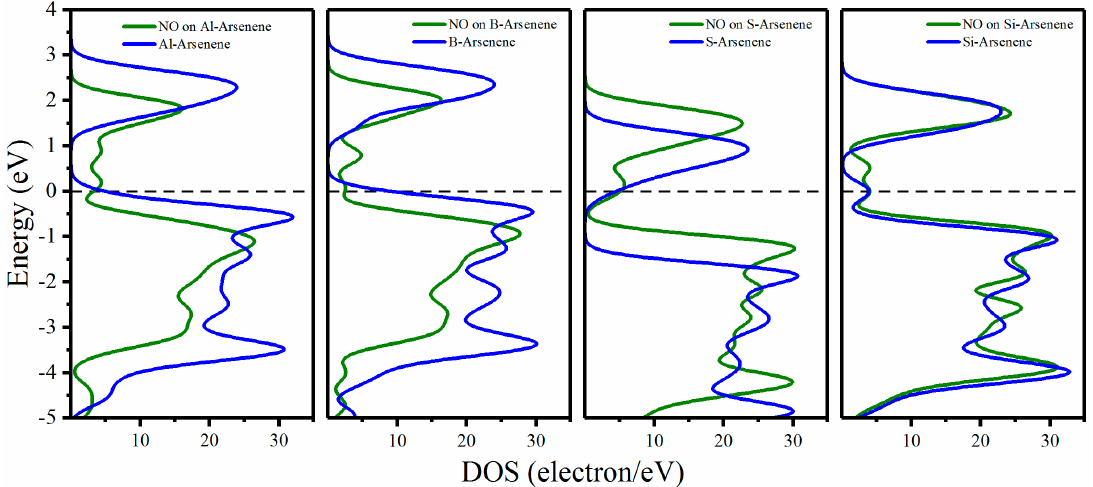
Figure 5. The density of states (DOS) of four systems. Blue and green lines present the DOS of substrates before and after NO adsorption, respectively.